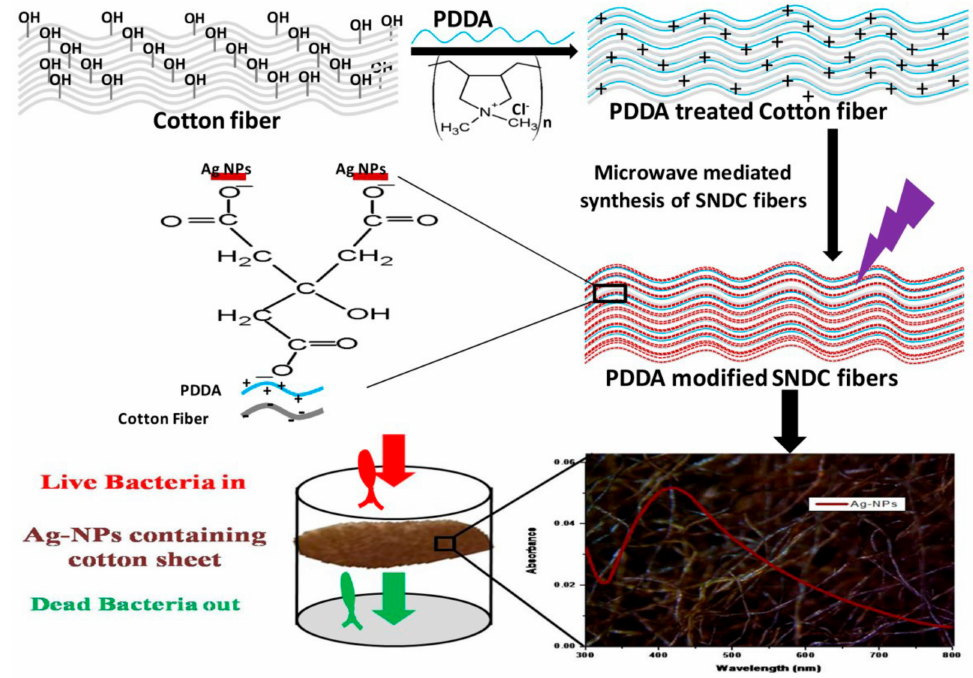
Figure 16. Diagram representing the entire protocol developed by Bhardwaj et al. Retrieved from